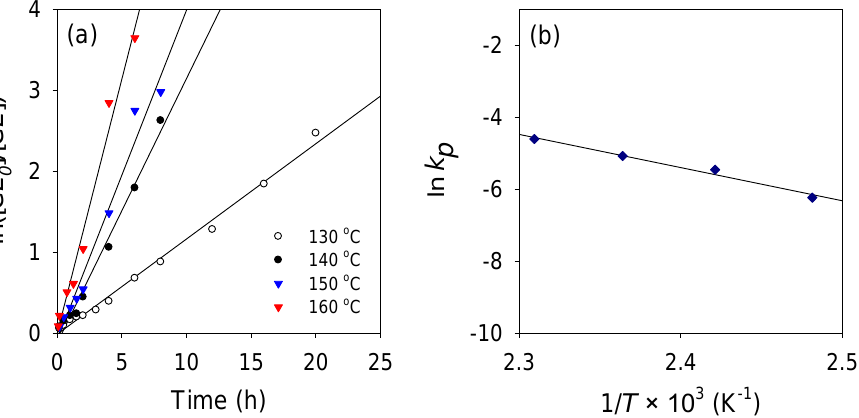
Figure 4. ( a ) First-order time–conversion plots of the batch polymerization of CL at different tem- peratures and ( b ) Arrhenius plot of the batch polymerization of CL. Conditions: DMC-EAA = 10 mg ([ Zn ] 0 = 30 mM), [ CL ] 0 = 9 M, [ CL ] 0 /[ GL ] 0 = 20. Table 4. Kinetic results for the ROP of CL at different temperatures using DMC-EAA catalyst (Zn) and GL initiator. T p Run 1